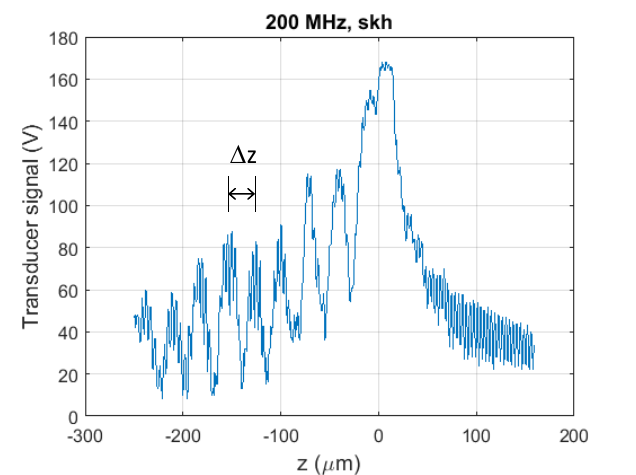
Figure B1. Typical V ( z ) curve. Surface acoustic-wave velocity can be obtained from ∆ z